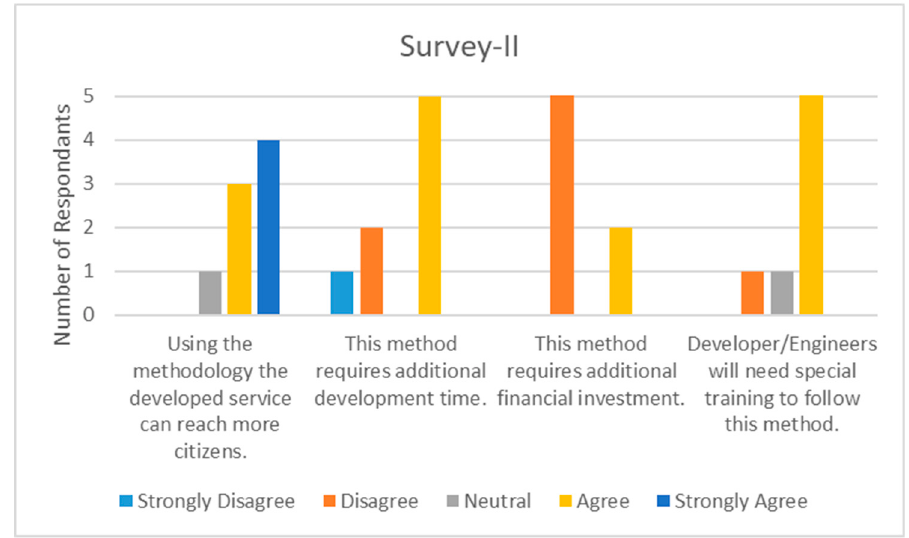
Figure 8. Perspective from Software Professionals on the method.